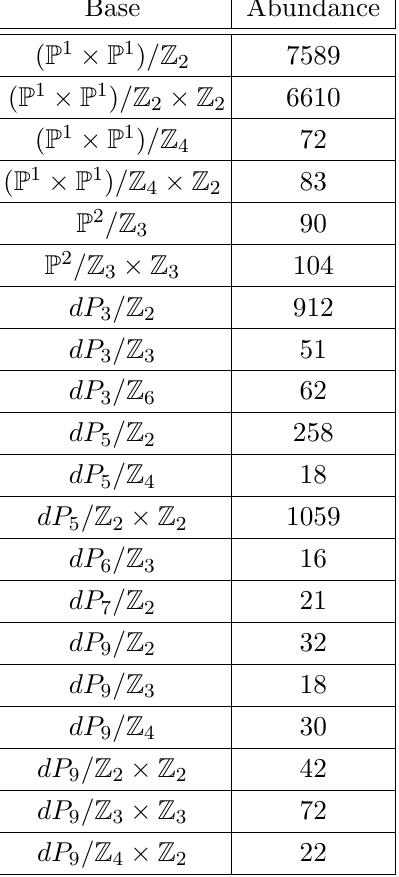
Figure 2 . An example of the data describing a (cid:12)bration of a quotiented